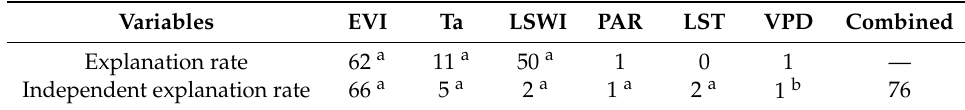
Table 4. Explanation rate (%) of a single variable of the GPP’s fluctuations derived from linear regressions and the independent explanation rate and total explanation rate (%) of each variable derived from stepwise multiple linear regression at the four grassland eddy flux tower sites. a , significant at the 0.01 level; b , significant at the 0.05